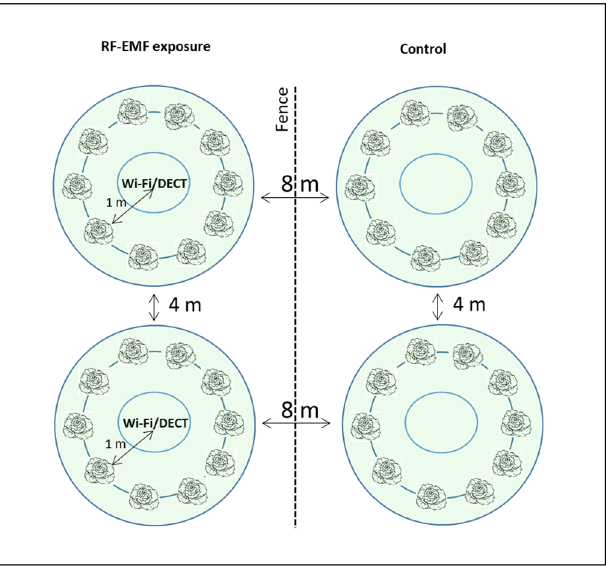
Figure 8. Experimental setup—RF ‐ EMF exposure of lettuce plants in the outdoor experiments .